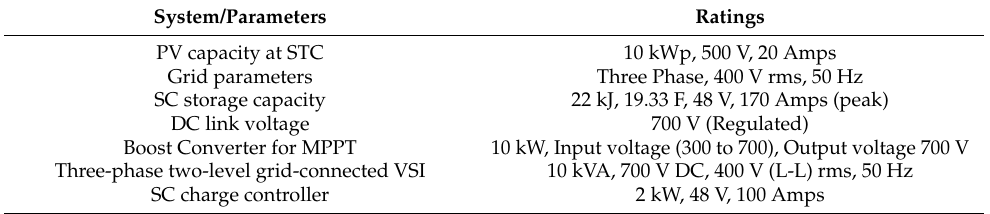
Table 1. System under consideration for the proposed